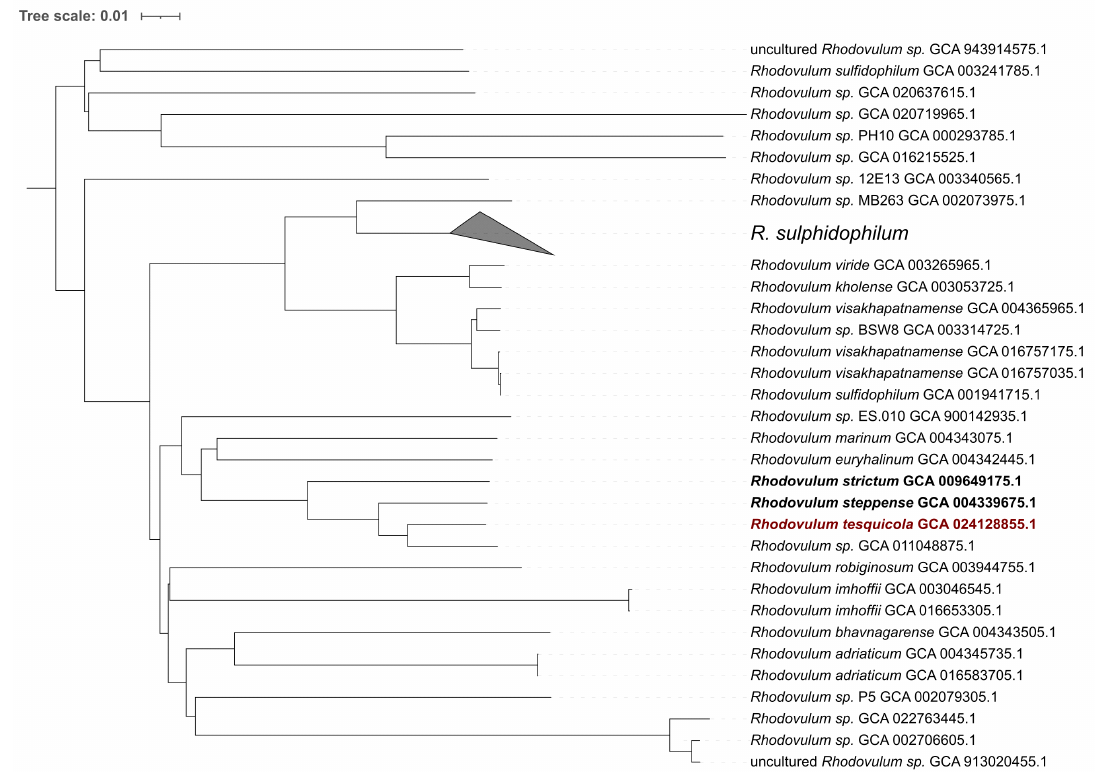
Figure 2. ANI dissimilarity dendrogram of high quality public Rhodovulum genomes. The dendro- gram is rooted at the midpoint and scaled by genomic distance between strains.